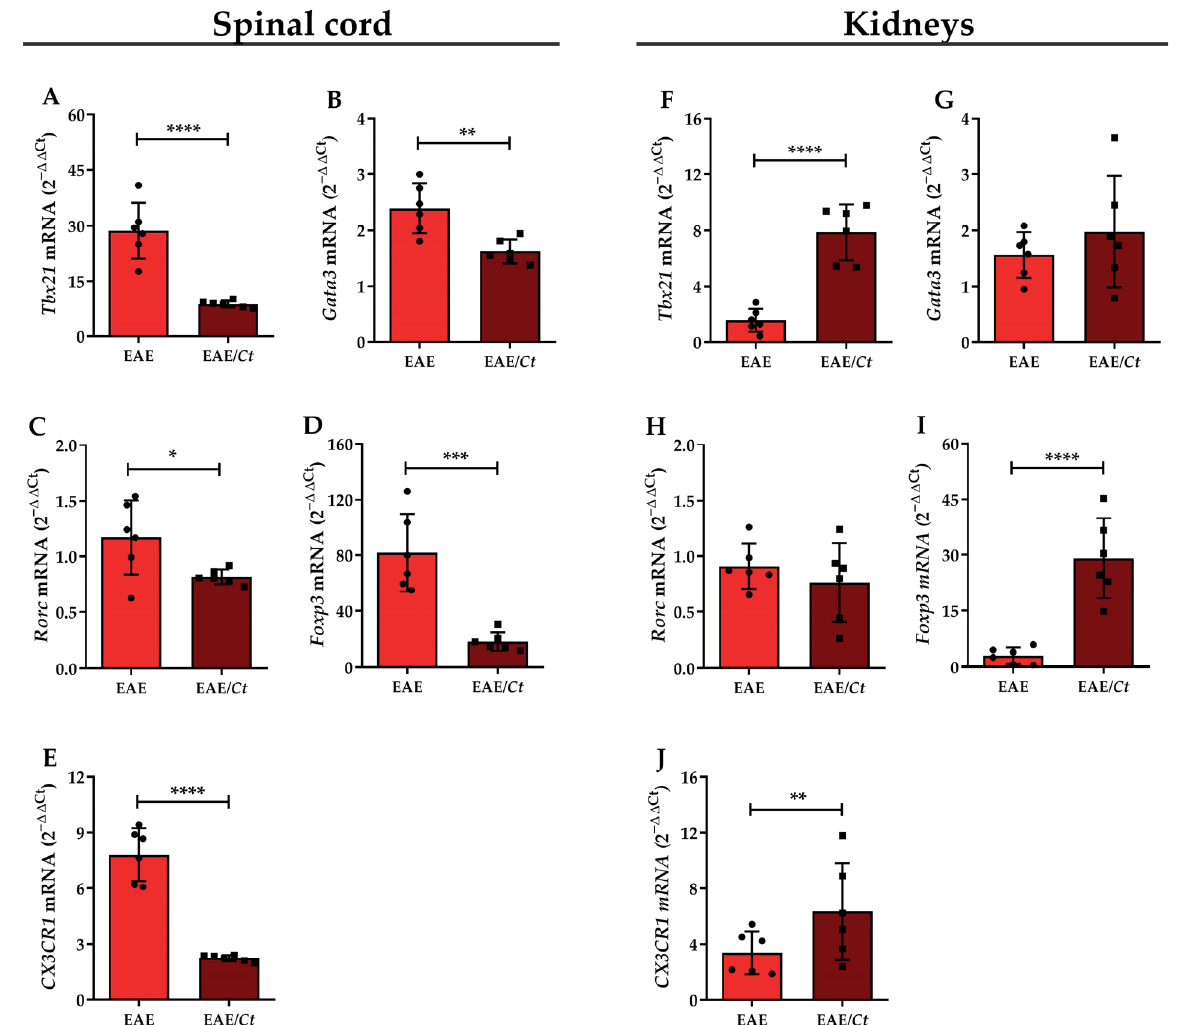
Figure 10. T lymphocyte subpopulations in EAE mice. Female C57BL/6 mice were infected with 1 × 10 6 viable C. tropicalis yeasts three days before EAE induction and evaluated for relative expression of Tbx21 , Gata3 , Rorc , Foxp3 , and CX3CR1 mRNA in the lumbar cord ( A – E ) and kidney ( F – J ) homogenate on the 16th day after EAE induction. The results are expressed as mean ± SD; n = 6/group, one representative experiment of two; * p < 0.05; ** p < 0.01; *** p < 0.005, and **** p < 0.001.